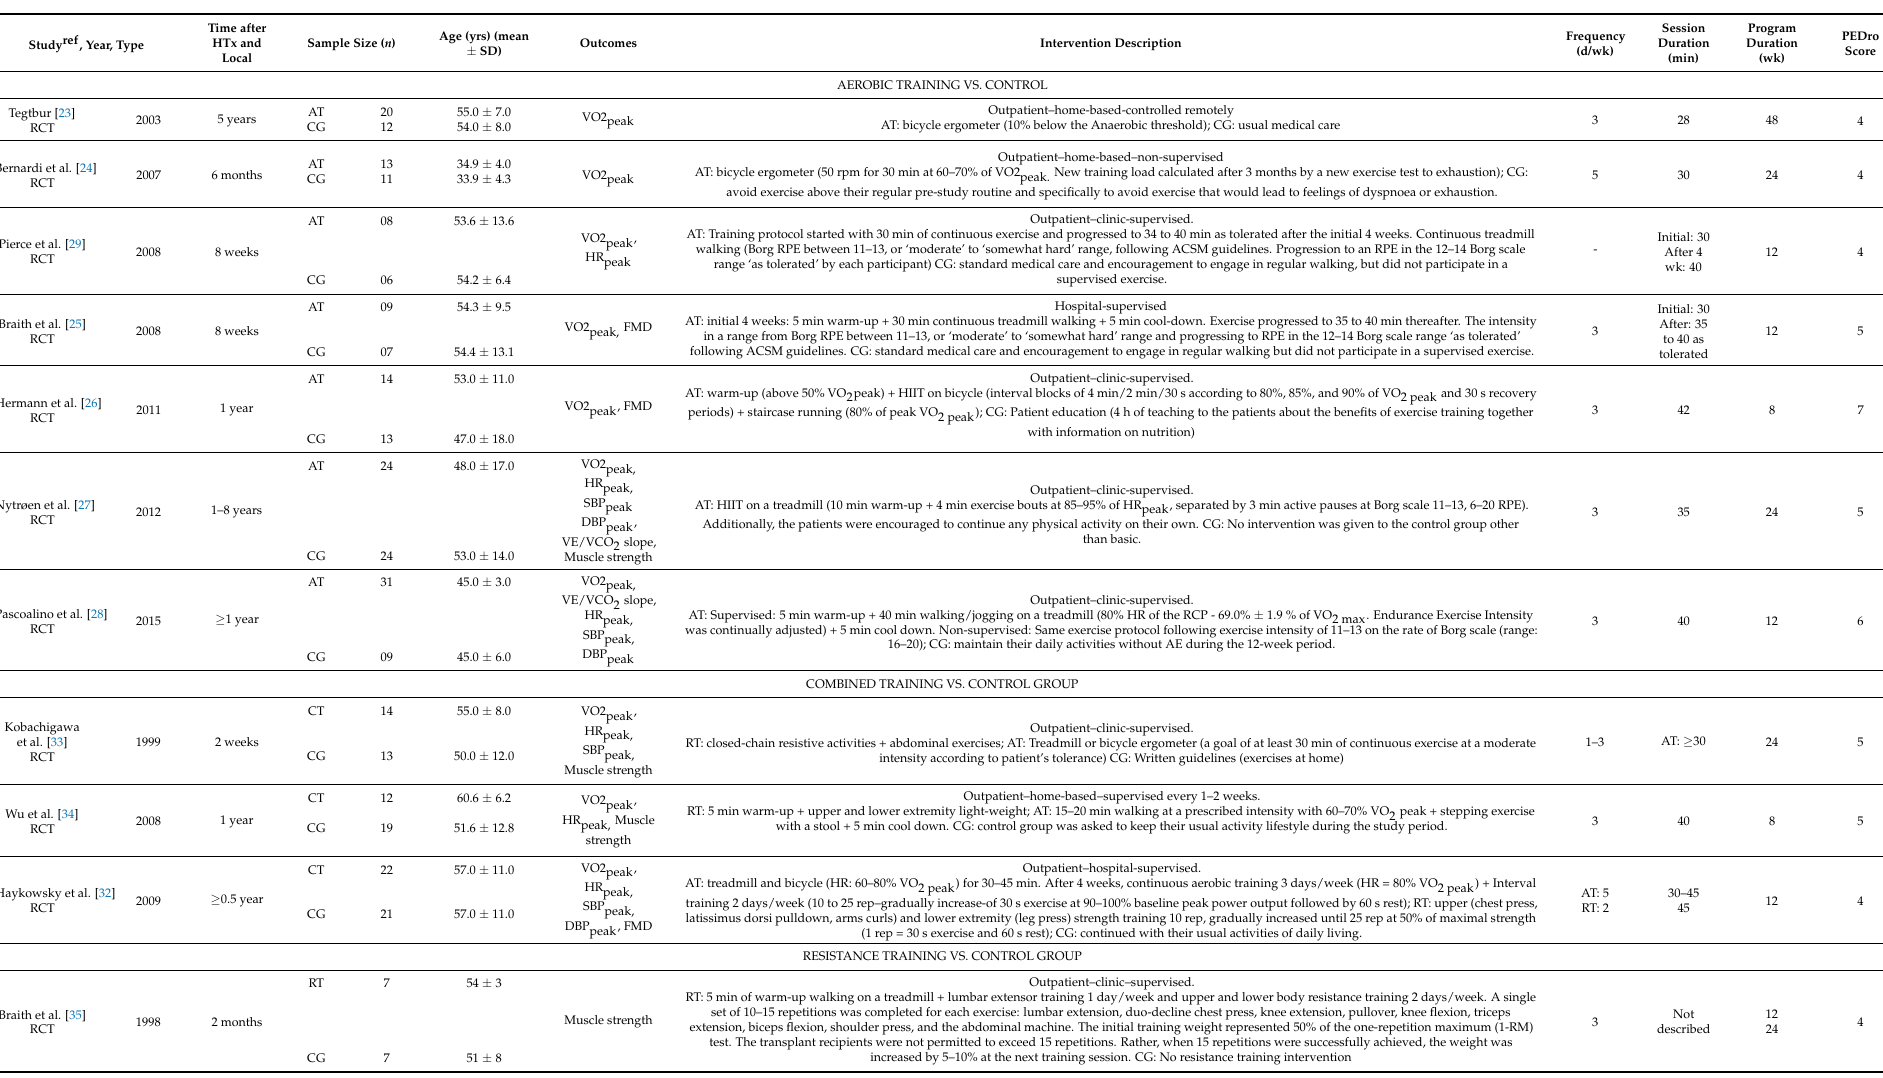
Table 1. Description of studies included in the systematic